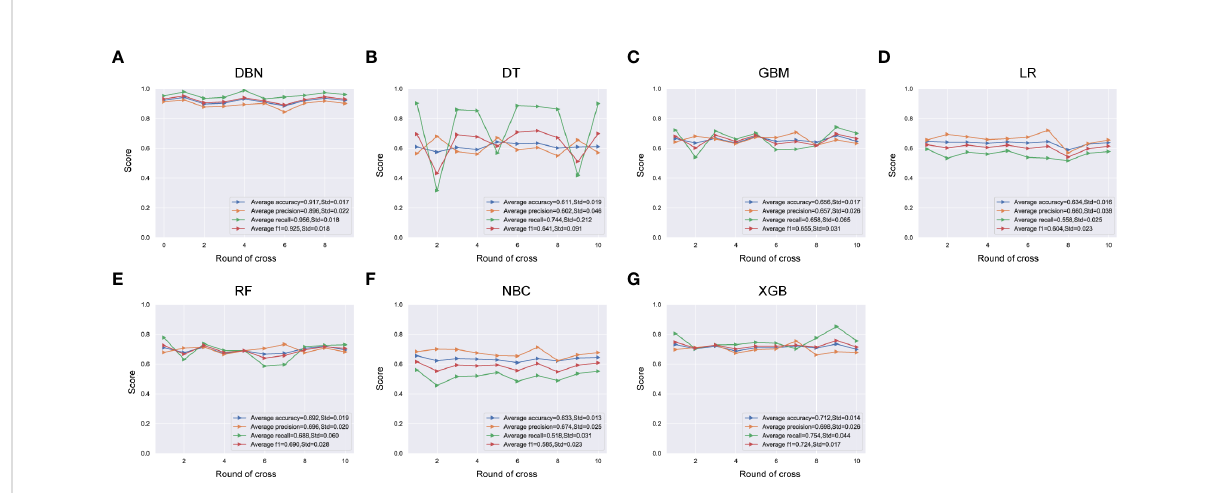
FIGURE 2 Comparison of DBN (A) algorithm and other 6 machine learning algorithms including DT (B) , GBM (C) , LR (D) , RF (E) , NBC (F) and XGB (G) for accuracy, precision, recall, and F-measure (F1-Score) in training set. DBN, Deep Belief Networks; DT, Decision Tree; GBM, Gradient Boosting Machine; LR, Logistic Regression; RF, Random Forest; NBC, Naive Bayes Classi fi er; XGB,